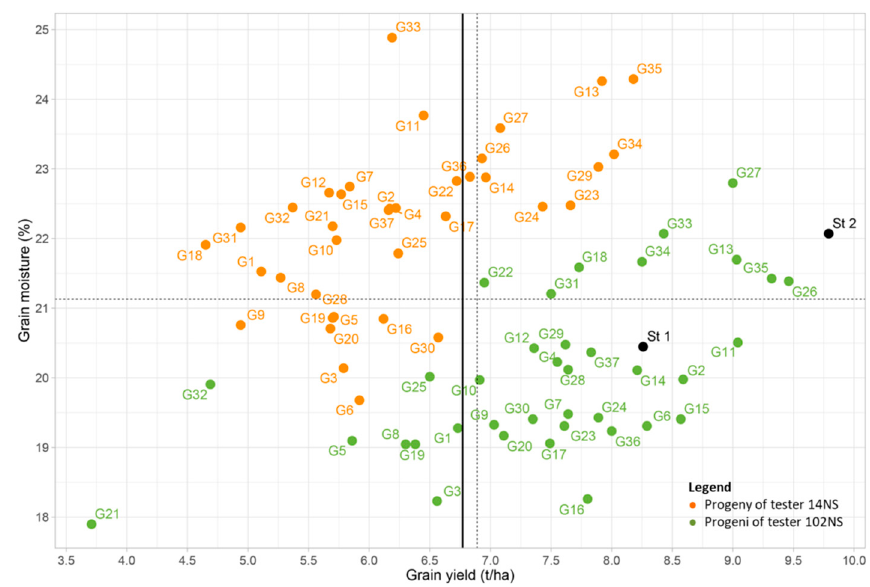
Figure 4. Scatterplot of grain yield vs. grain moisture for evaluated top-crosses .